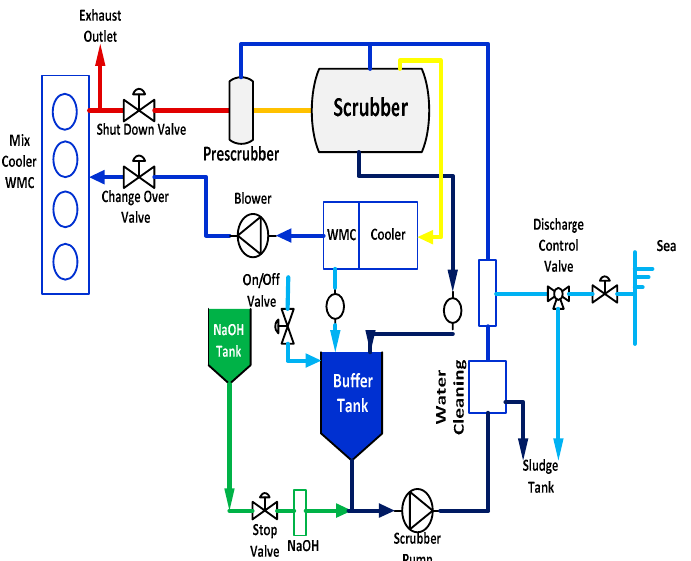
Figure 4. Graphical representation of an EGR system installed on a marine diesel engine for NO x emissions reduction. The specific installation incorporates a closed-loop system with scrubbers operating with fresh water and NaOH for the reduction of marine diesel engine emitted SO x and PM. (Figure was genuinely generated using data from refs. [34,35]).